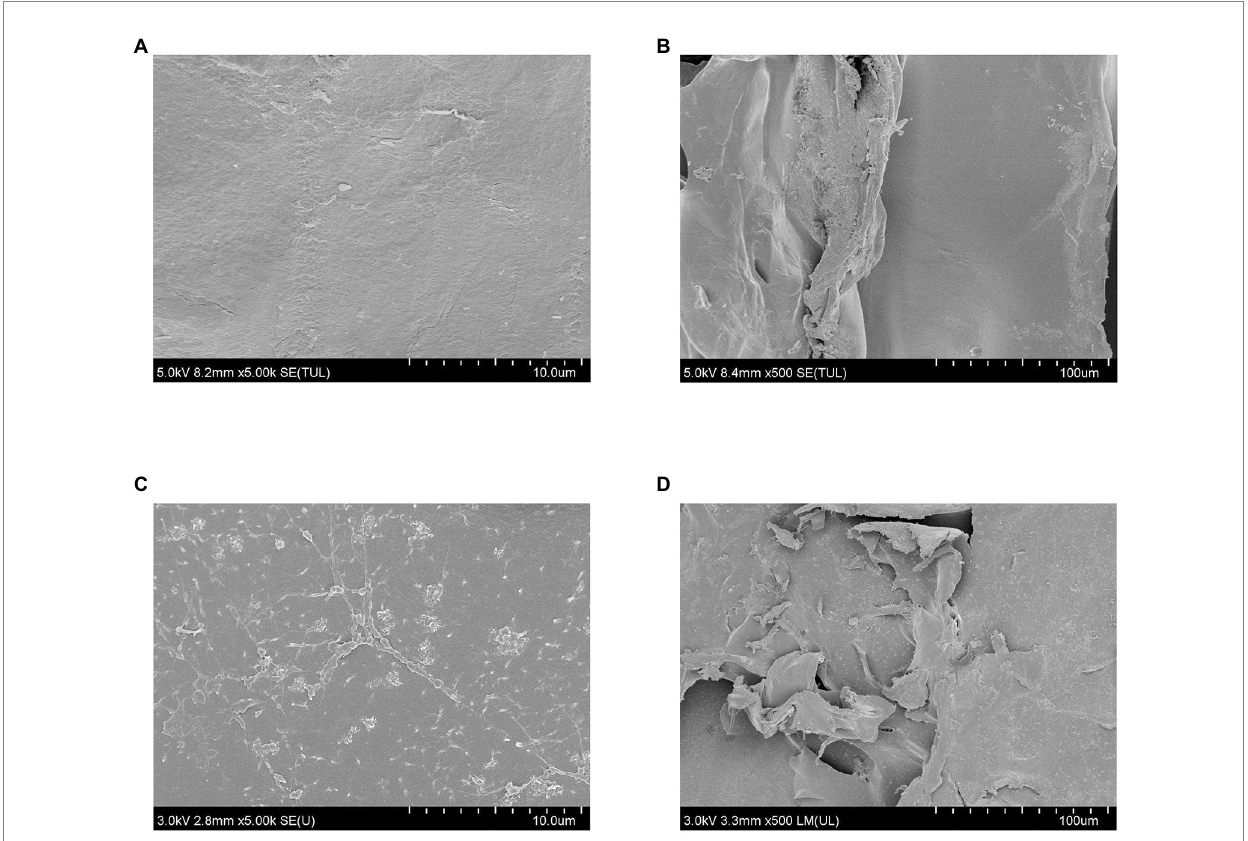
FIGURE 8 Morphological changes of WIP during in vitro fermentation. (A,B) SEM of WIP before fermentation, (C,D) SEM of WIP after